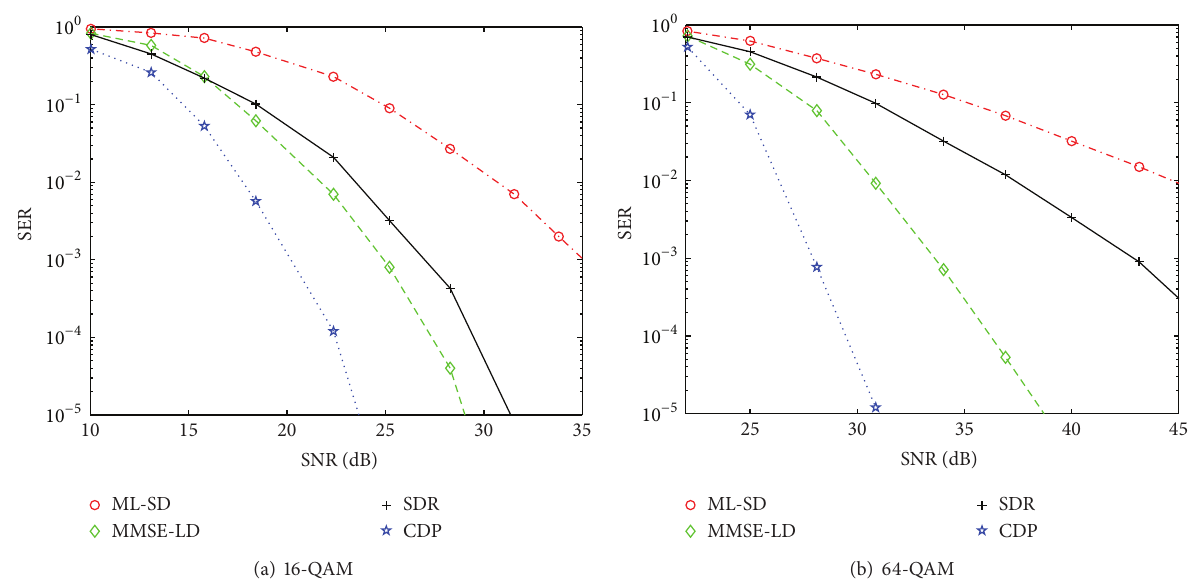
Figure 2: Symbol error rate comparison for different methods, (𝑚,𝑛) = (16,16)